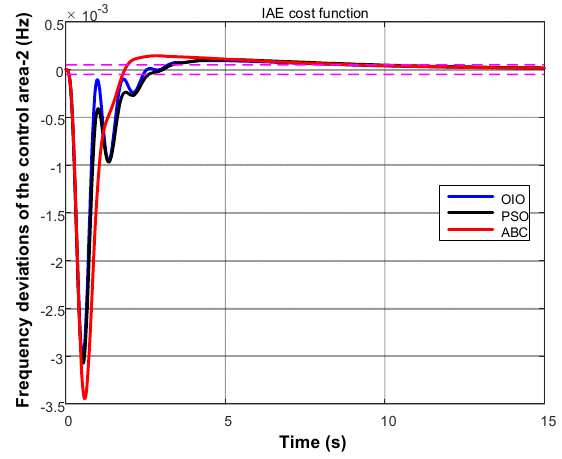
Figure 8. Change in frequency of area ‐ 2 for IAE.